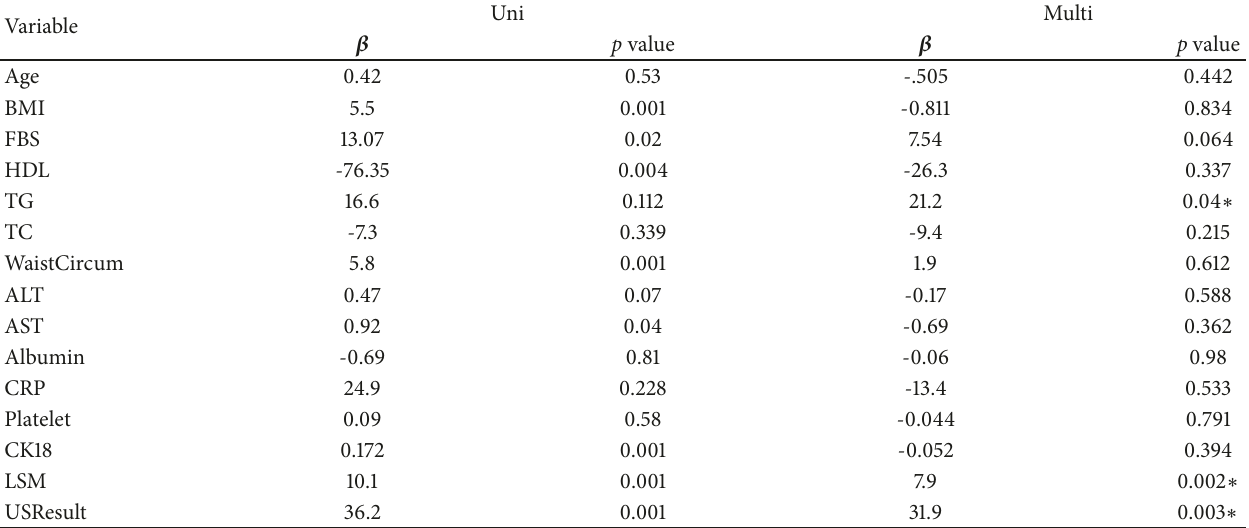
Table 5: Factors Influencing CAP (controlled attenuation parameter) in fibroscan. Using Univariate and Multivariate Linear Regression Analysis. Β : beta coefficient. Uni: univariate regression analysis; Multi: multivariate regression analysis. BMI: Body Mass Index; FBS: fasting blood sugar; HDL: high-density lipoprotein; TG: triglyceride; TC: total cholesterol; ALT: alanine transaminase; AST: aspartate transaminase; CRP: C-reactive protein; CK18: cytokeratin-18; LSM: liver stiffness measurement; US: ultrasonography; ∗ :